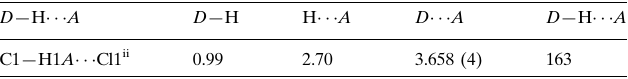
Hydrogen-bond geometry (A˚ , (cid:2)